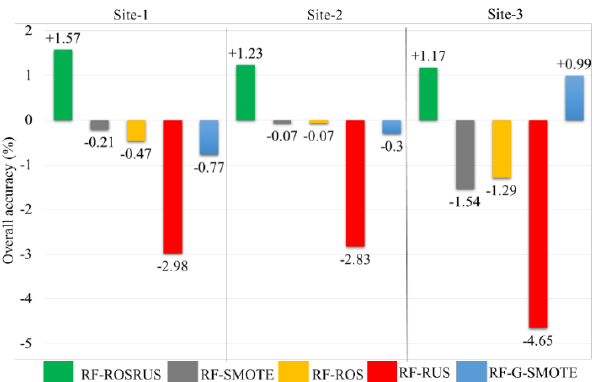
Figure 13. Performance of different resampling methods in improving overall classification accuracy compared to the Scenario-4 classification method (i.e., RF with imbalanced samples).